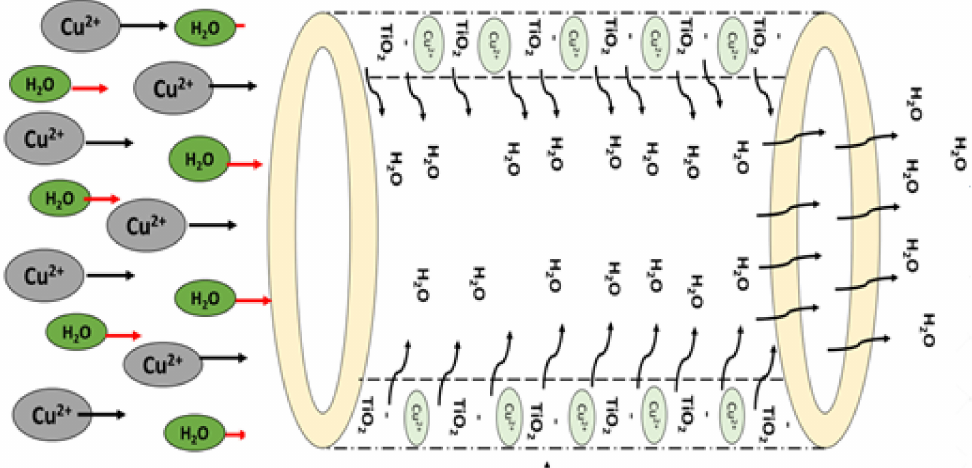
Figure 6. Copper removal mechanism on membrane matrix